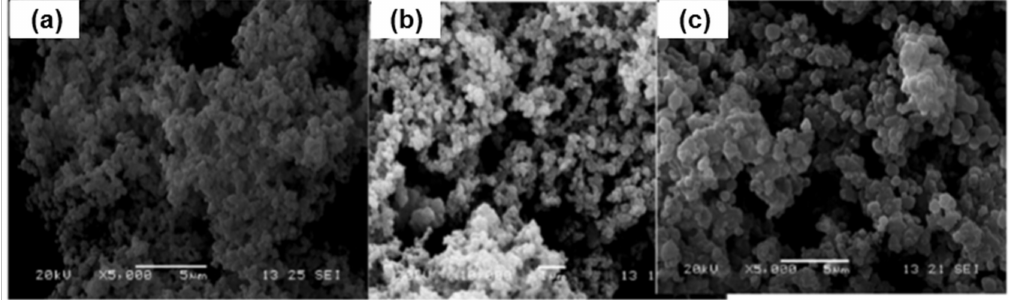
Figure 8. SEM images of MIPAM with various crosslinkers: ( a ) 3:1; ( b ) 4:1; ( c ) 5:1